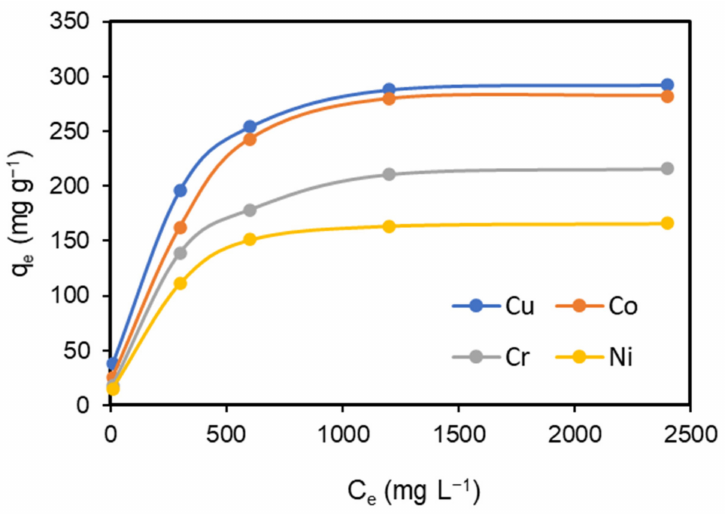
Figure 6. The effect of different initial heavy metal ion concentrations on adsorption capacity by poly(amidoxime)